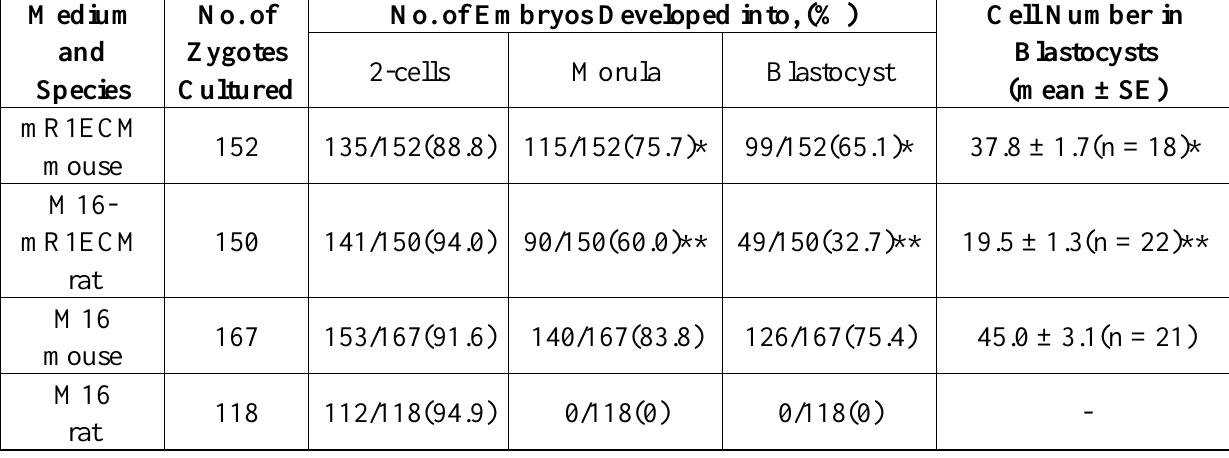
Table 2 . Influence of culture medium on in vitro development of mouse and rat